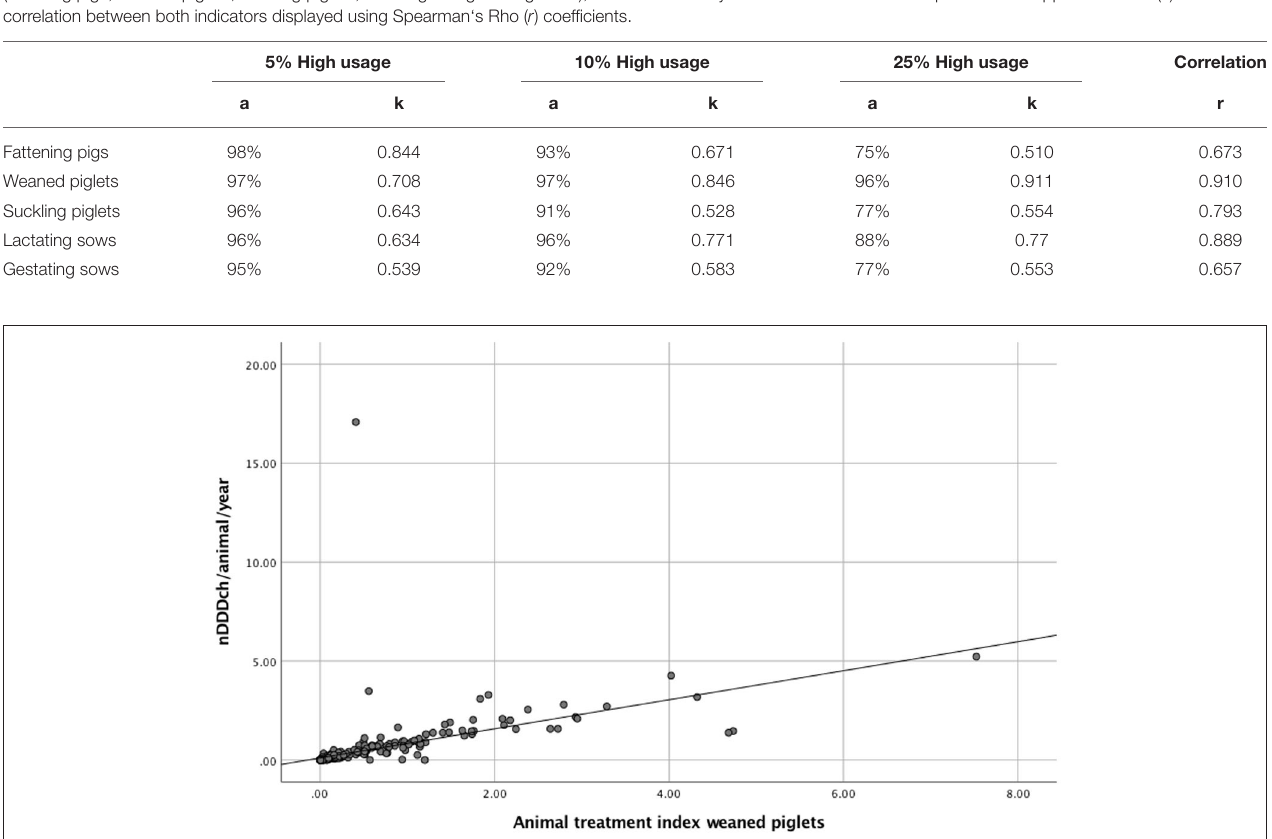
FIGURE 1 | Scatterplots and linear regression of AMU calculated either as Animal Treatment Index (ATI) or the number of DDDch/animal/year (nDDDch/animal/year) for weaned piglets from 360 study farms.